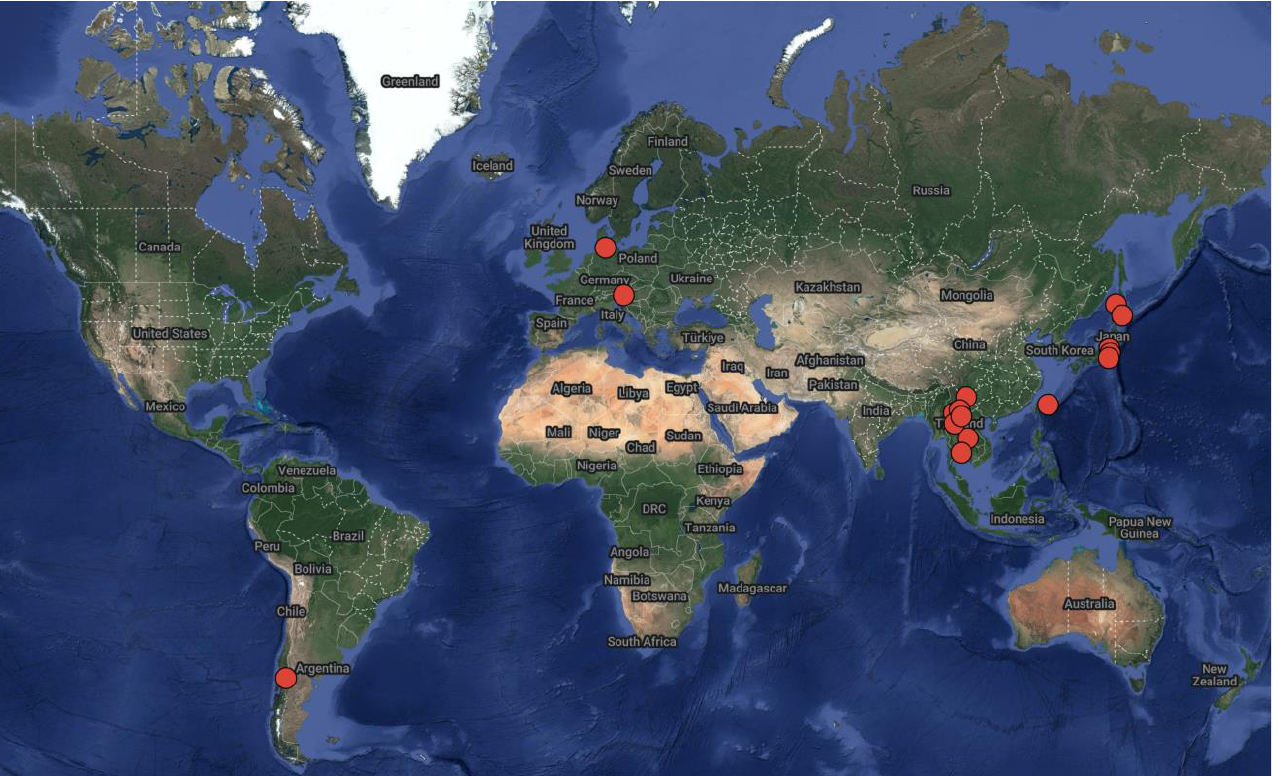
Figure 1. Collection points for lichen samples (the red dots represent the sampling sites).